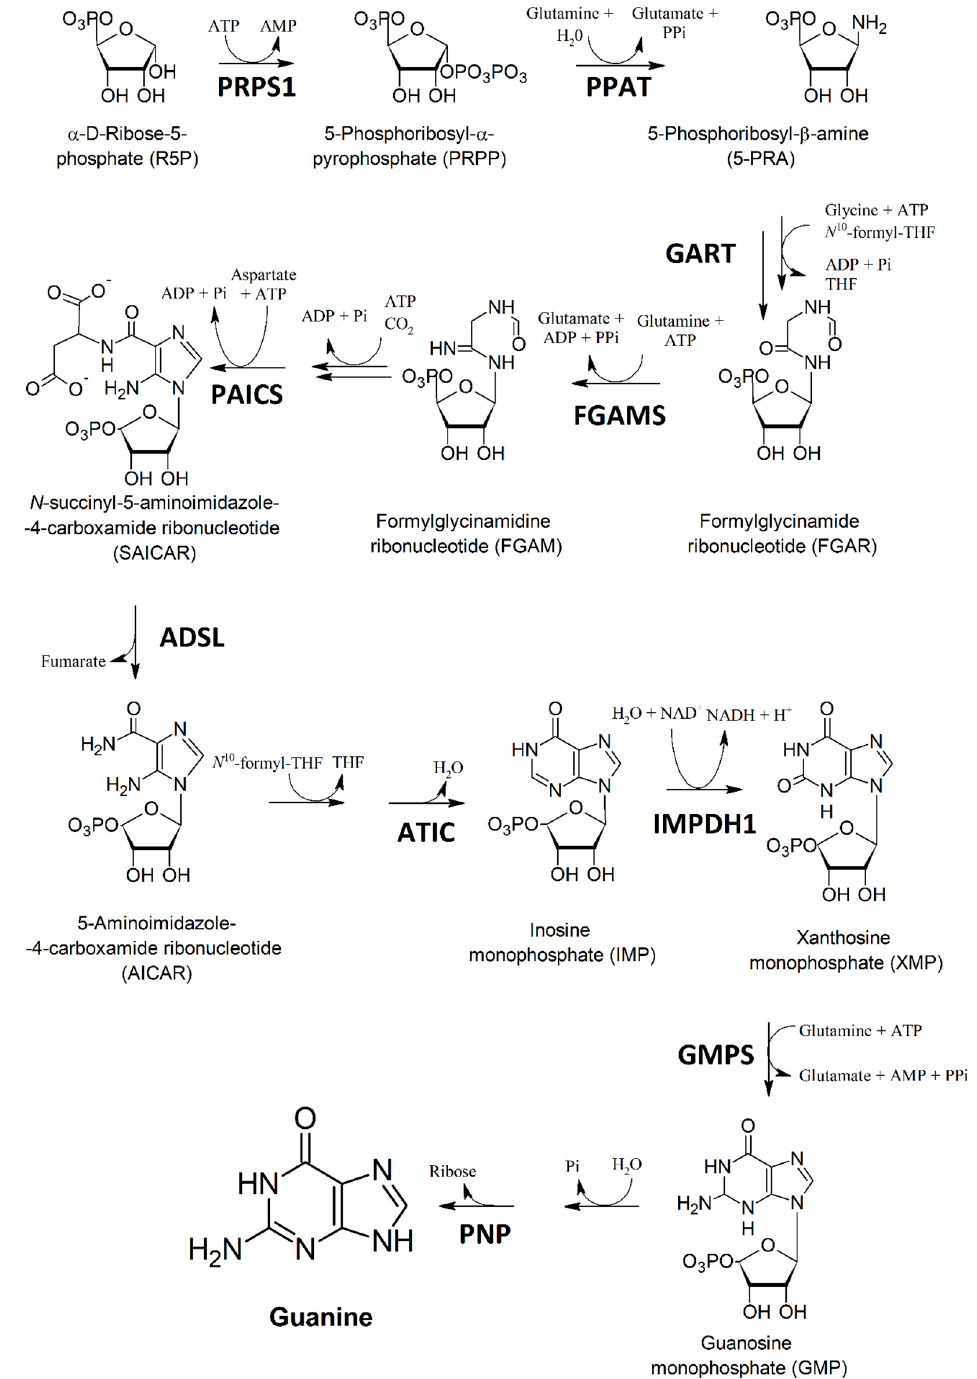
Figure 4. Biosynthetic pathway of guanine. (PRPS1) 5-phosphoribosyl-1-pyrophosphate synthetase; (PPAT) glutamine phosphoribosyl pyrophosphate aminotransferase; (GART) glycinamide ribonucleotide formyltransferase; (FGAMS) phosphoribosyl formyl glycinamidine synthase; (PAICS), phosphoribosylaminoimidazolesuccinocarboxamide synthase; (ADSL) adenylosuccinate lyase; (ATIC) AICAR transformylase/IMP cyclohydrolase; (IMPDH1) IMP dehydrogenase; (GMPS) GMP synthetase; (PNP) Purine nucleotide phosphorylase.